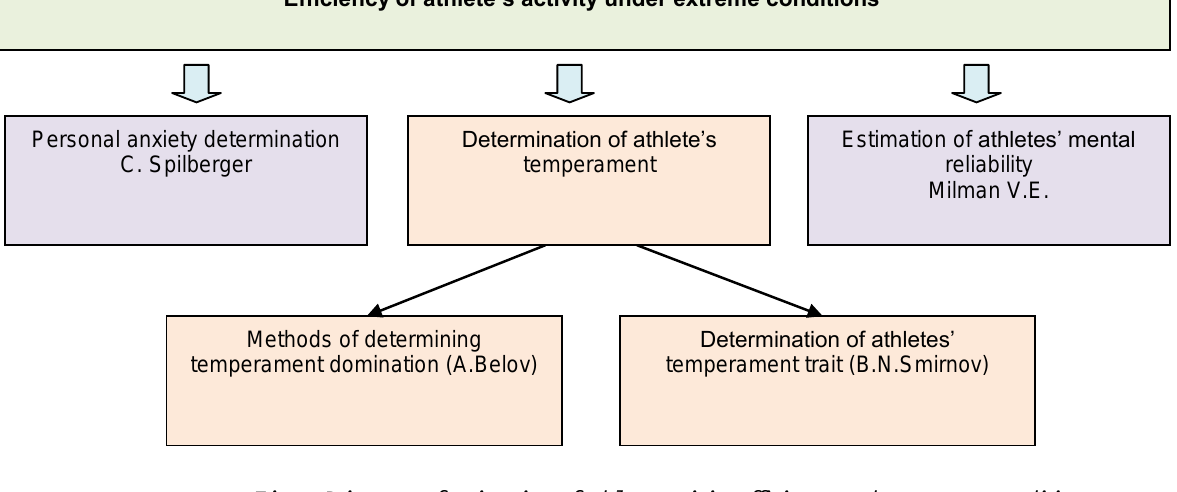
Fig. 7. Diagram of estimation of athlete activity efficiency under extreme